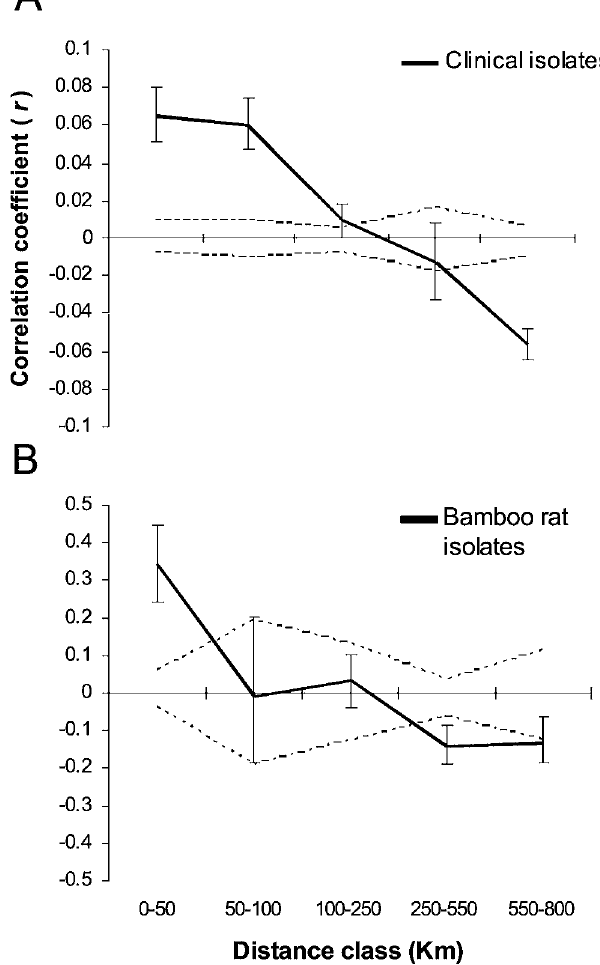
Figure 3. Correlograms Showing the Correlation Coefficient r as a Function of Distance for Human Clinical Isolates and Bamboo Rat Isolates Data for (A) human clinical isolates and (B) bamboo rat isolates. Values for r are shown as solid lines with 95% CIs calculated by bootstrapping the dataset. Also shown are the 95% CIs around the null hypothesis of randomly distributed genotypes of P. marneffei, calculated over 1,000 permutations of the data, shown as dotted lines. DOI: 10.1371/journal.ppat.0010020.g003